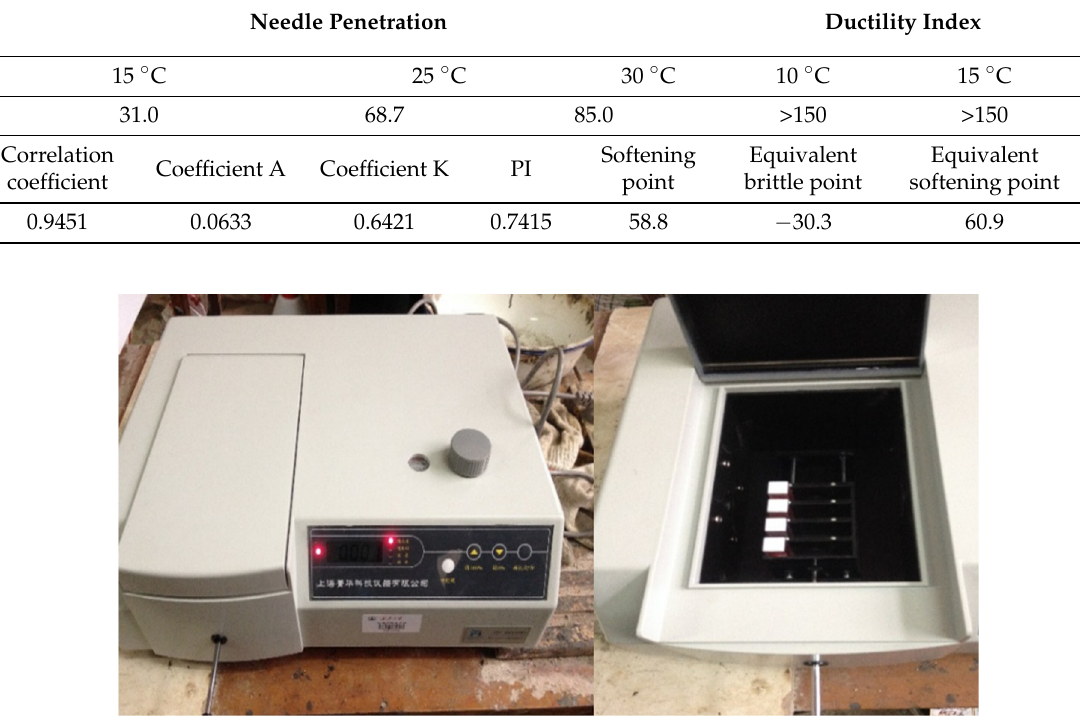
Figure 20. Type 717 spectrophotometer.